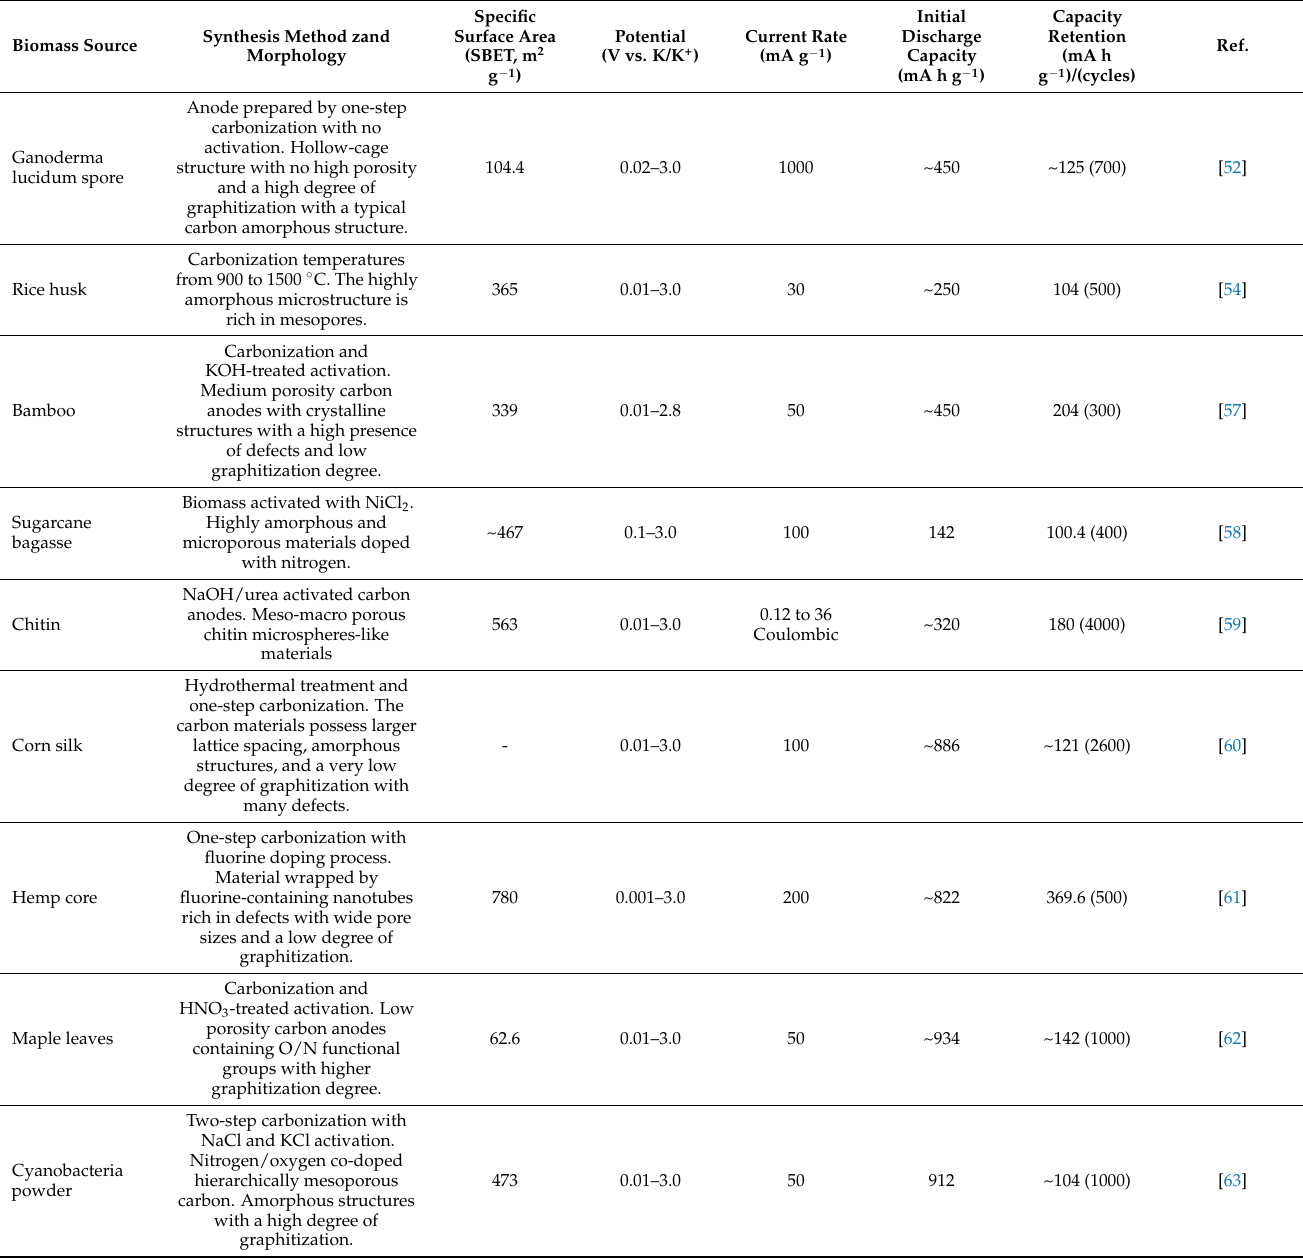
Table 1. Comparative electrochemical performance of biobased carbon material anodes for